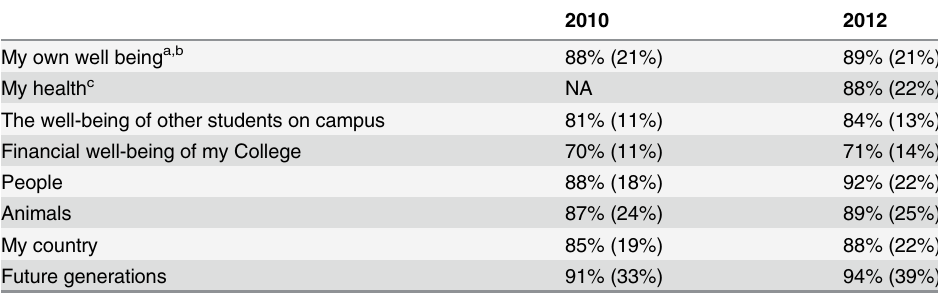
Table 5. Degree to which different factors motivate conservation.